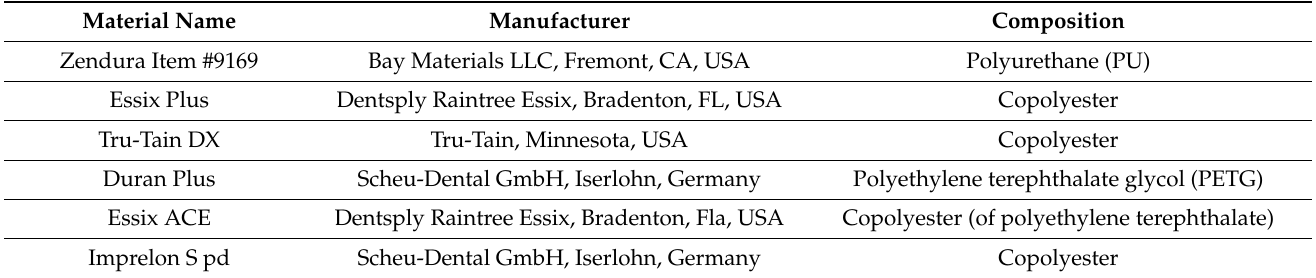
Table 1. Thermoplastic retainer materials used in the current study. The reported composition of each material in this table is according to its material safety and data sheet.